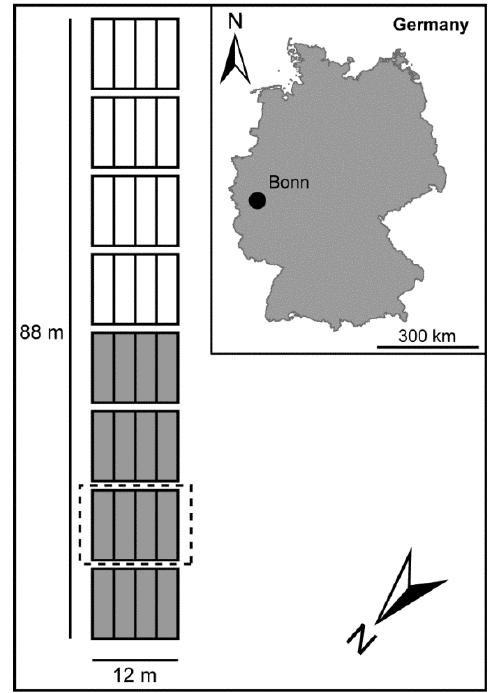
Figure 1. Orientation map and sketch of study area; white: treated plots, grey: untreated plots, dashed line: plot